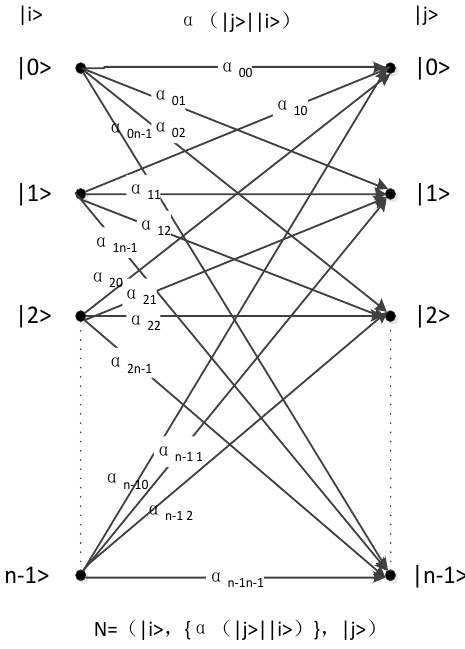
Figure 3. Quantum coefficient channel.